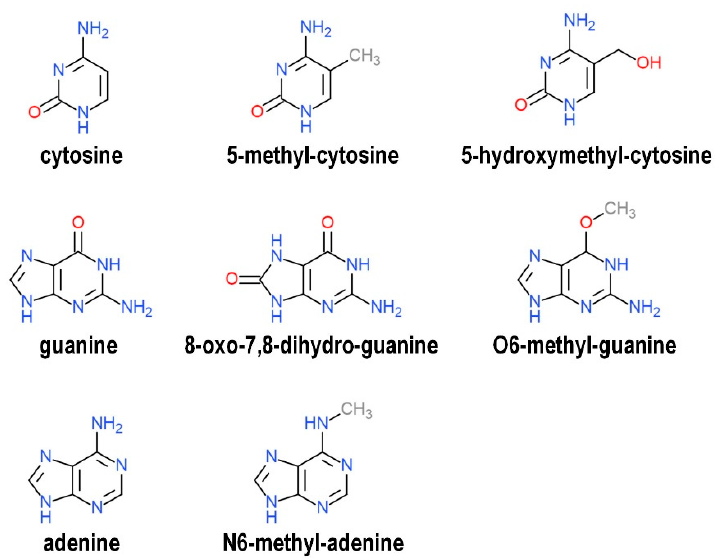
Figure 2. Chemical structure of canonical and biochemically modified nitrogenous bases discussed in this